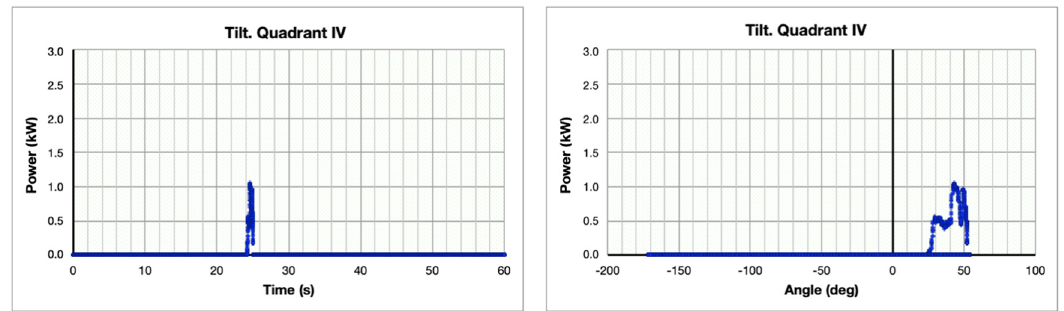
Figure 17. Recoverable power vs. time ( left ) and angle ( right ) for the tilt actuator in quadrant II.